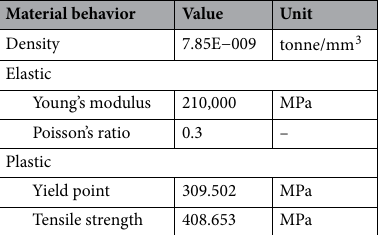
Table 3. Behavior of steel in finite element